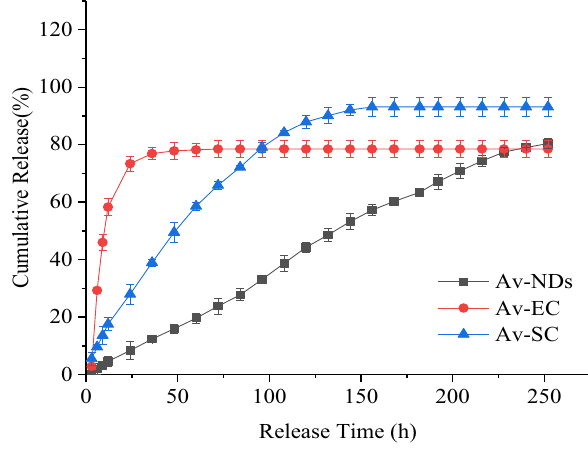
Figure 8. Release curve of Av-NDs in 70% methanol aqueous solution.